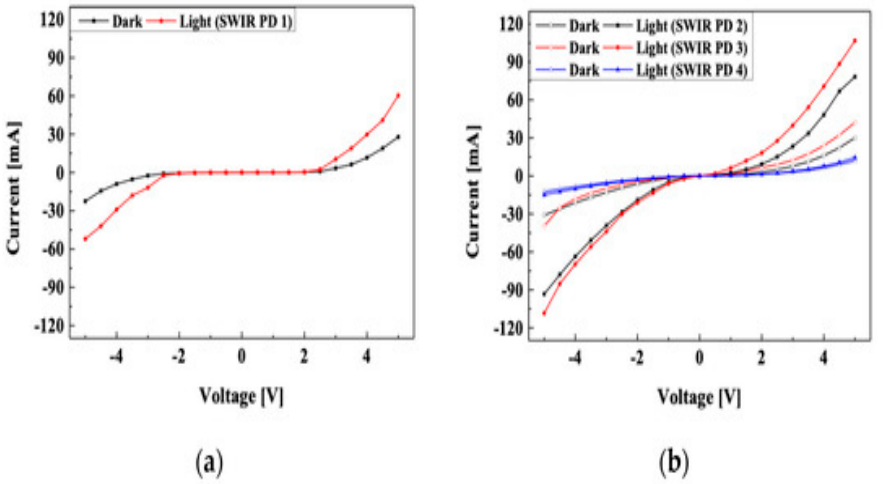
Figure 2. I–V characteristics of ( a ) PbS SWIR photodetector without P3HT polymer and ( b ) PbS SWIR photodetector with P3HT polymer [84].